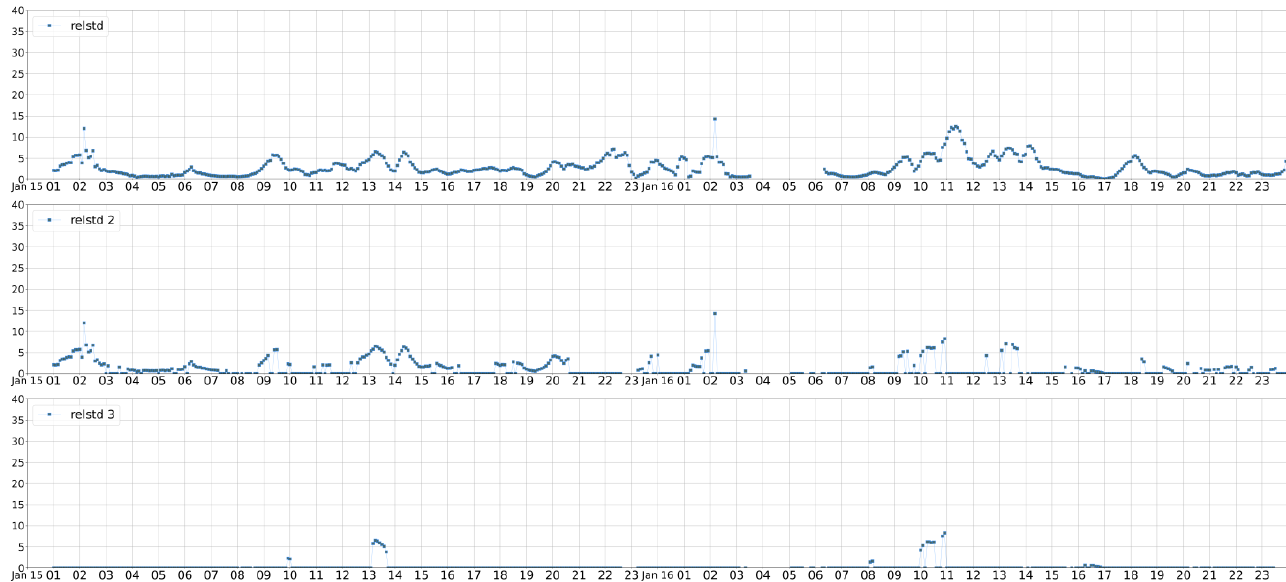
Figure 12. The variability of the relstds for the period 15–16 January 2022, as a result of the imple- mentation of the LSTID identification criteria over data collected from the Athens Digisonde.